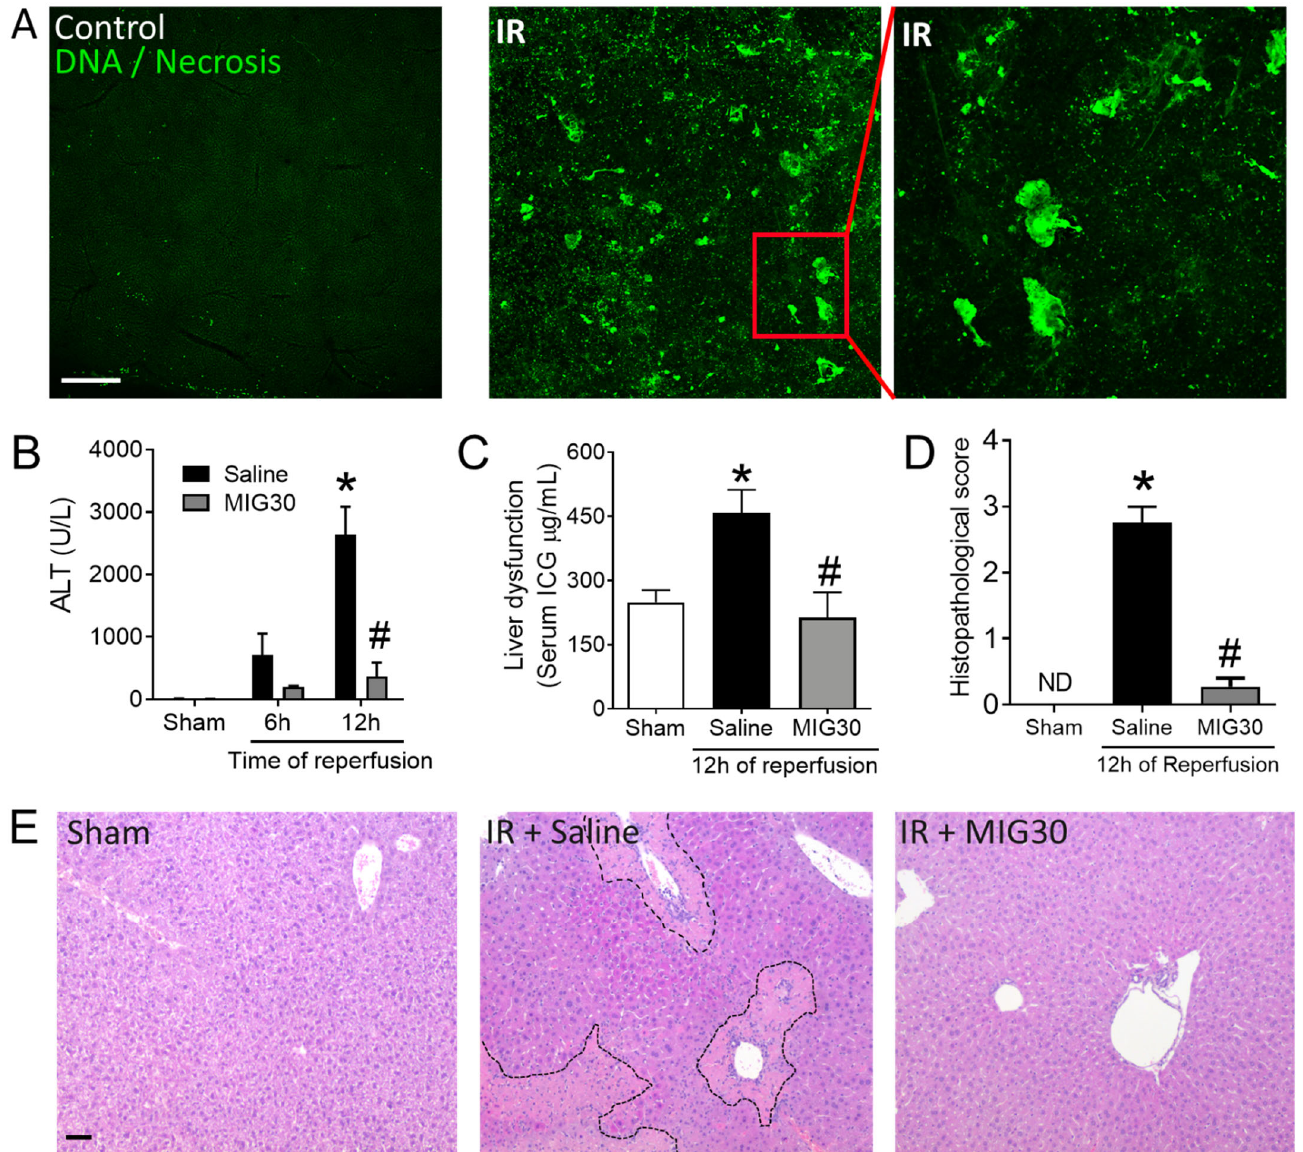
Figure 2. Treatment with MIG30 protects mice from liver ischemia ‐ reperfusion injury (IRI). ( A ) Confocal intravital microscopy of the liver of mice subjected to sham (control) or 8 h of ischemia ‐ reperfusion (IR) injury. Extracellular DNA and injured areas were stained by Sytox green injected intravenously. ( B ) Serum alanine aminotransferase (ALT) levels of mice subjected to different times of IR injury. IR mice were treated i.v. with saline vehicle or with MIG30 (100 µ g 15 min before the reperfusion and again 6 h later). ( C ) Serum level of indocyanine green (ICG) showing the severity of liver dysfunction induced by IRI. Mice were treated with saline or MIG30 as in B. ( D ) Histopathol ‐ ogy quantification of liver sections stained with H&E. ( E ) Representative H&E staining images of livers 12 h post ‐ IR injury. ND = Not detected. The data shown is mean ± SEM; n is at least 4 mice per group. * p < 0.05 vs. sham group; # p < 0.05 vs. saline ‐ treated mice. Scale bars = 100 μ m.